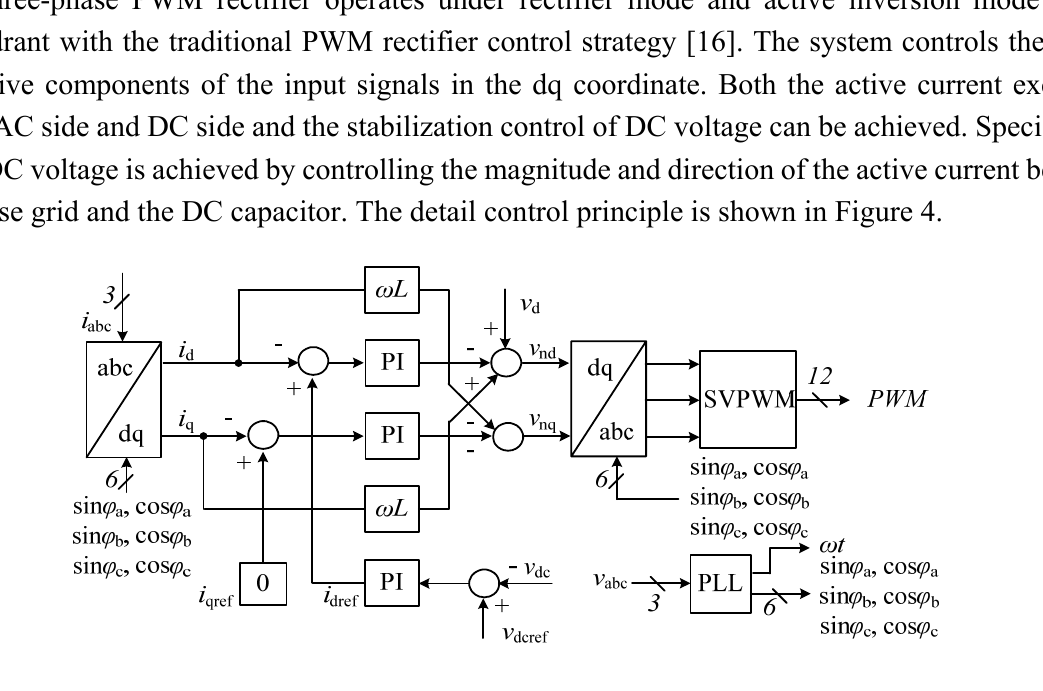
Figure 4. Block control diagram of the three-phase PWM